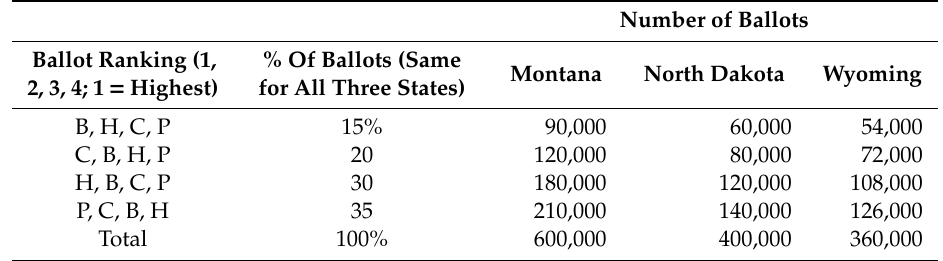
Table 5. Ballot percentages and number of ballots by ballot ranking of Beech (B), Cherry (C), Holly (H), and Peach (P), for three states (2024 election, Scenario 3).